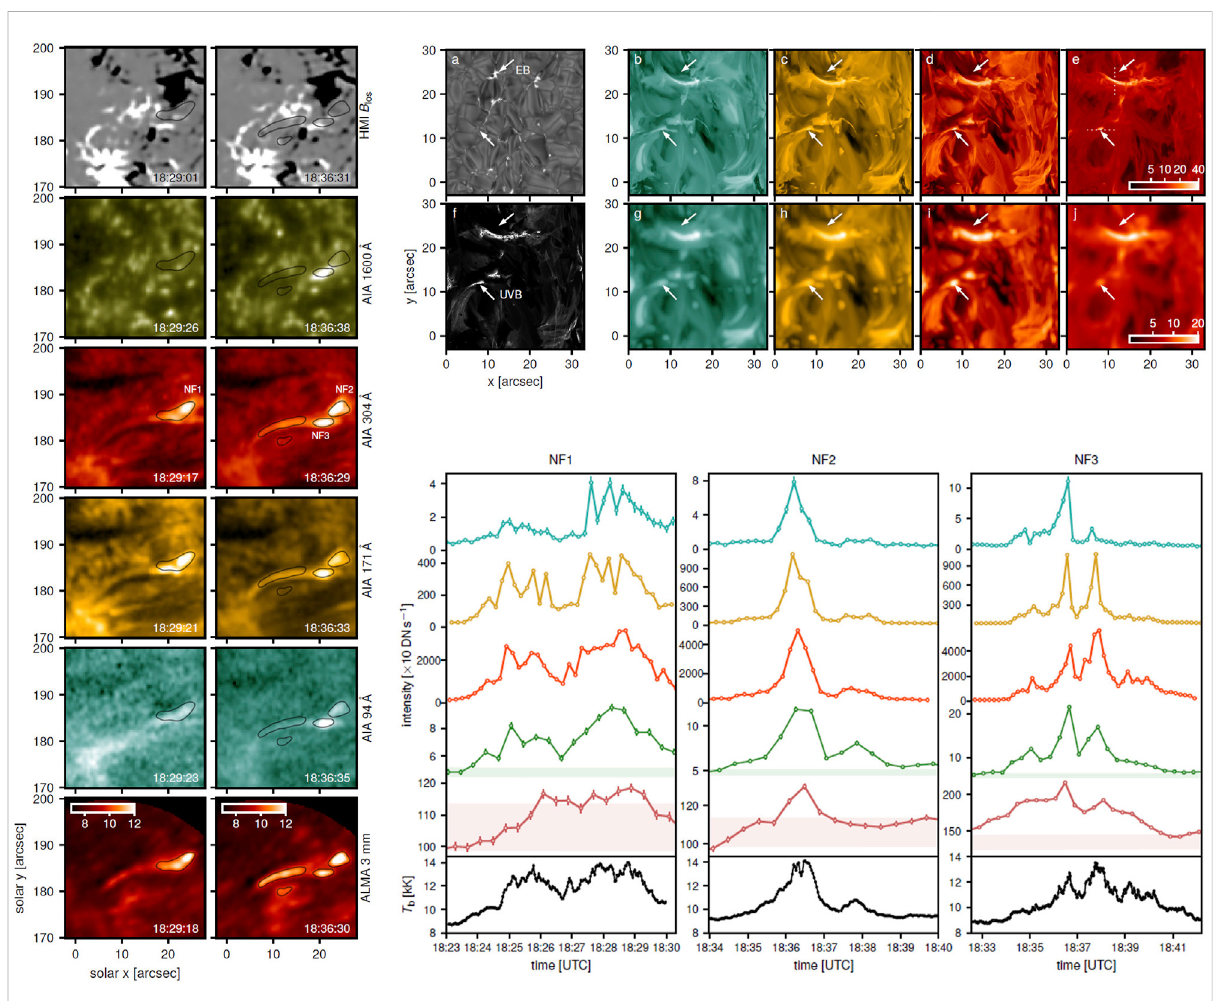
FIGURE 10 The two leftmost columns show characteristic snapshots of fl aring fi brils in an HMI magnetogram, several AIA channels and ALMA 3 mm data. Thecontoursmarka3-mmbrightnesstemperatureof10 4 K.Thetworowsatthetop-rightpartofthe fi gureshowresultsfromanr-MHDsimulation. Panels (A , F) showH α linewingandintegratedSiIV1393 Åintensitywhilepanels (B – E) showthesimulation ’ semissioninAIA94,171,304 Åand3 mm, at its original spatial scale. In panels (G – J) the spatial resolution of the simulation has been degraded resulting to pixel size of 0.3 ″ . The top and bottom arrows mark the locations of an Ellerman bomb and a UV burst, respectively. The remaining columns at the bottom-right part of the fi gure show time pro fi les (3 mm, 1700, 1600, 304, 171, and 94 Å from bottom to top) of the events marked NF1, NF2, NF3 at the two left columns (adapted from da Silva Santos et al., 2020). Reproduced with permission ©